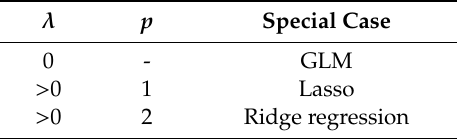
Table 1. Special cases of regularised